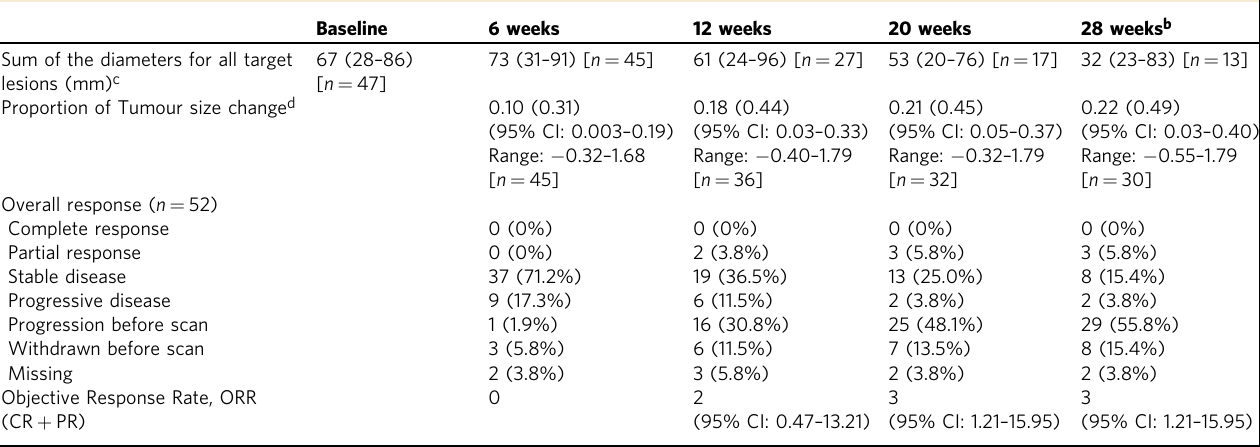
Table 4 Summary of tumour assessment based on central review a